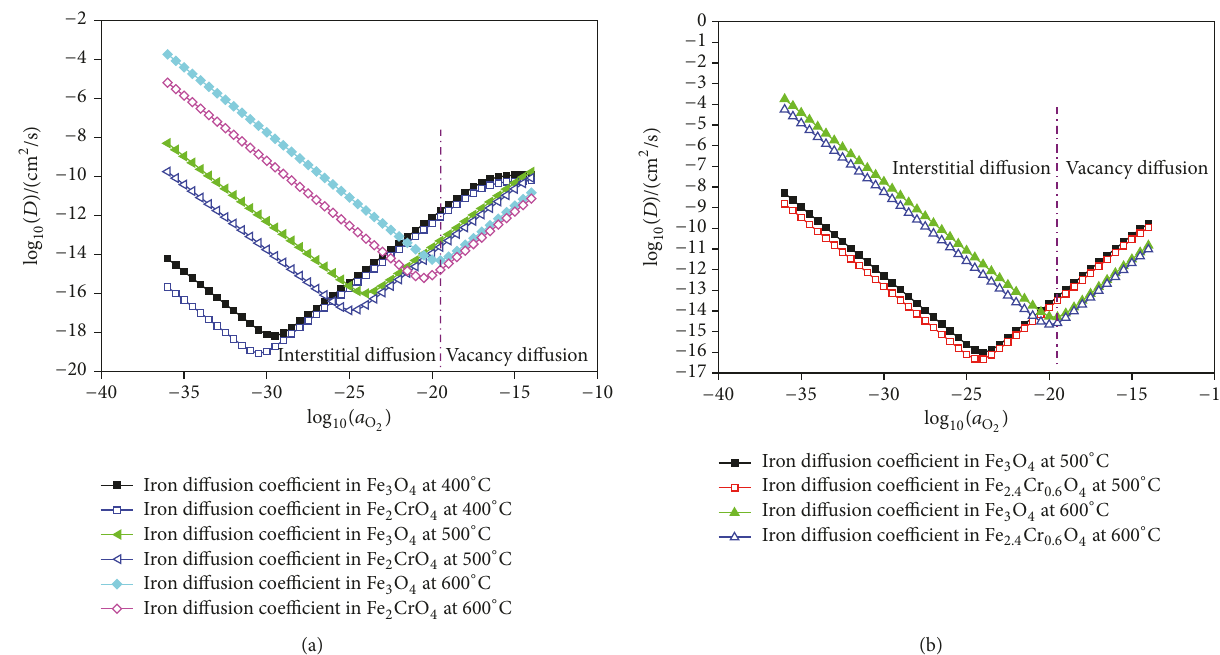
Figure 2: Iron diffusion coefficient of the duplex scale formed on HCM12A (a) and NF616 (b) as a function of oxygen activity in supercritical water at different